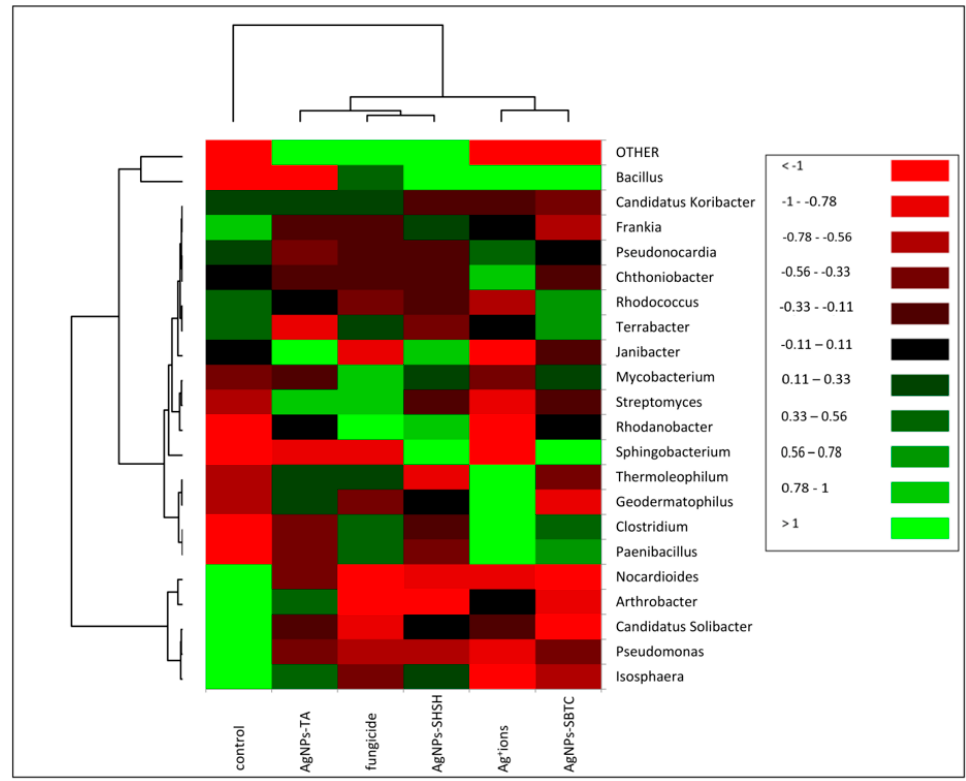
Figure 5. Heat map showing shifts in soil bacteria structure depending on the treatment.